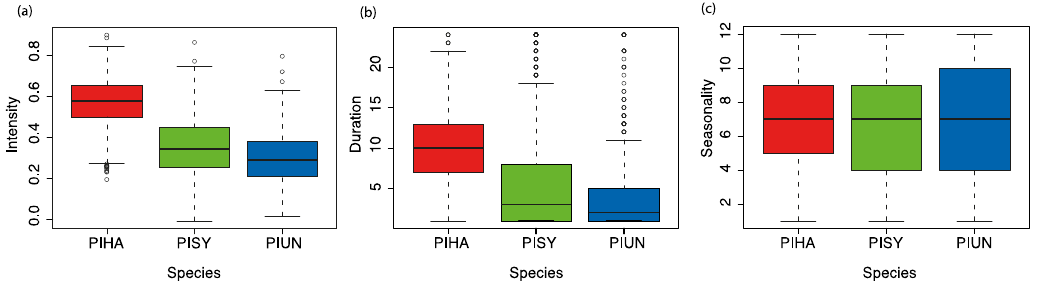
Figure 3. Boxplot of observed ( a ) intensity, ( b ) seasonality (in months), and ( c ) duration of drought effects (in months) of all analyzed sites. The central lines of boxplots indicate the median value, the vertical hinges indicate the first and third quartiles, the error bars indicate the 95% confidence interval of the median, and the small circles indicate values beyond the 95% confidence interval threshold. PIHA: P. halepensis ; PISY: P. sylvestris; PIUN : P. uncinata.